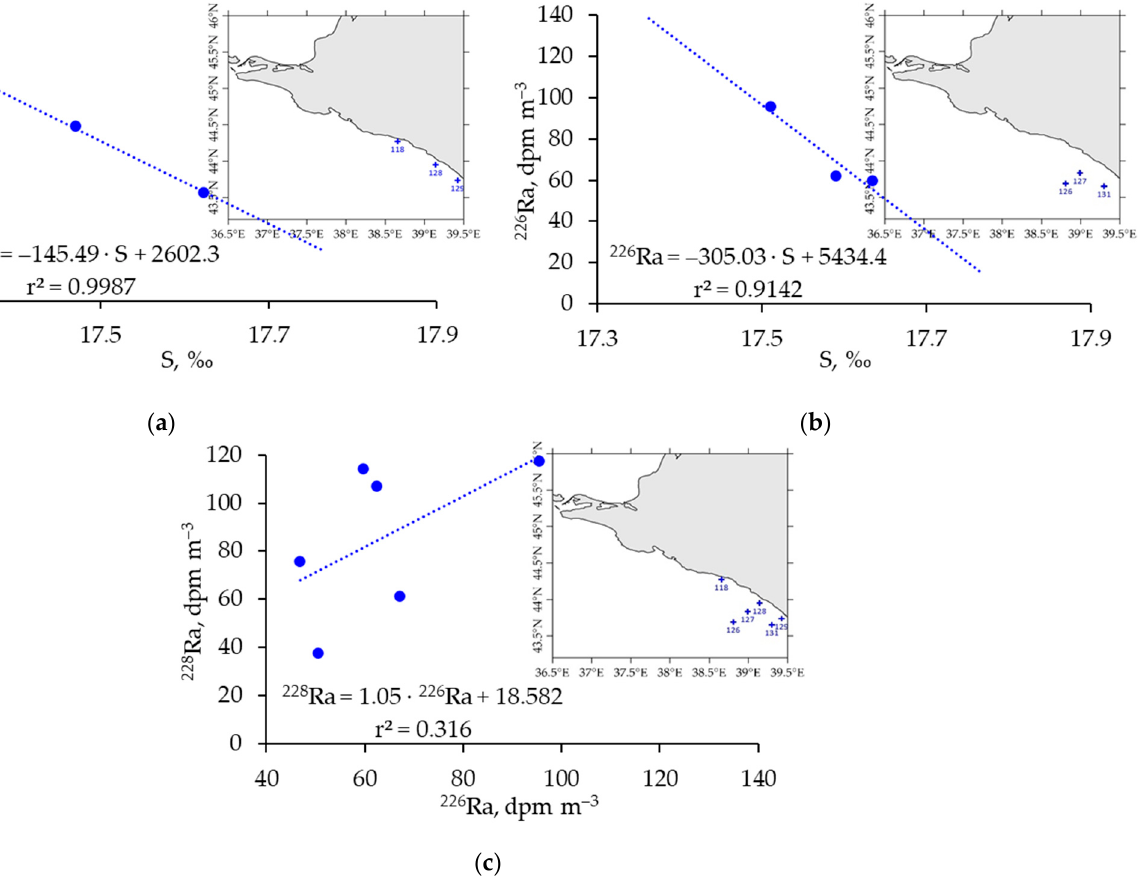
Figure 6. Dependence of 228 Ra ( a ), 226 Ra ( b ) concentration on salinity and the ratio of 228 Ra/ 226 Ra ( c ) for the least salty surface water region of the Caucasian coast (S < 18.0‰). The locations of seawater sampled stations are shown by crosses.